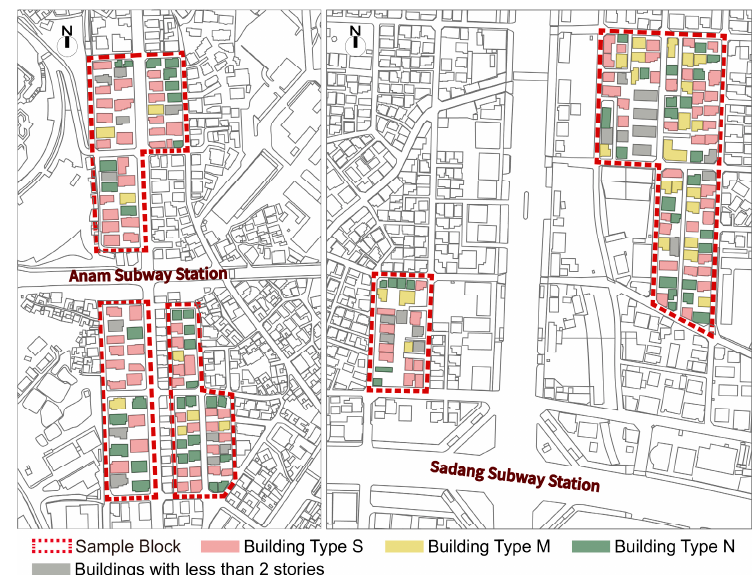
Figure 11. Distribution of all massing types.